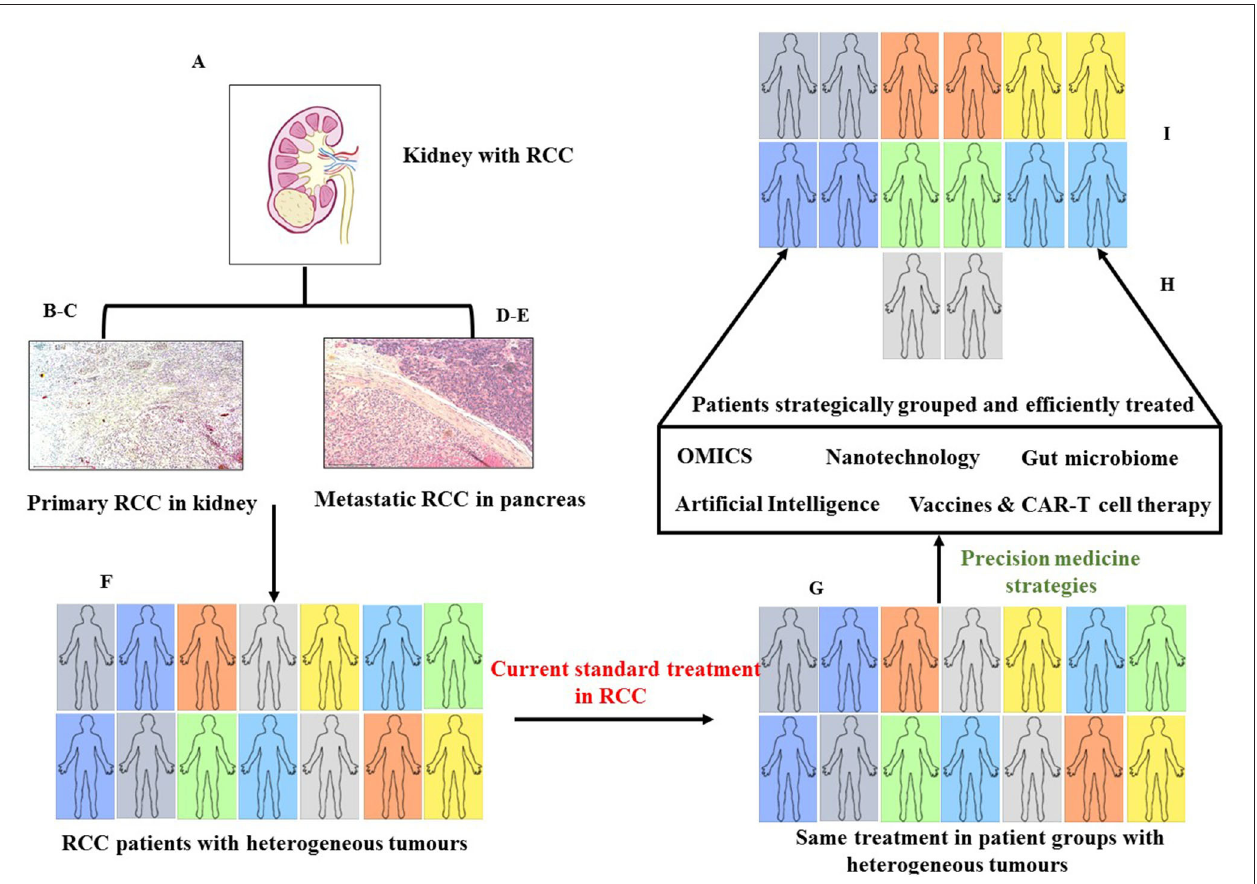
FIGURE 2 | Role of precision medicine (PM) in RCC. (A) Hematoxylin and Eosin (H & E) staining of human kidney with RCC, (B) H & E of primary RCC showing typical epithelial nests of RCC cells with clear cytoplasm (Magnification: 100X), (C) adjacent normal kidney tissue, (D) metastatic RCC invading the pancreas of a patient tissue, (E) adjacent normal spleen in a patient tissue (Magnification: 100X). (F) heterogeneity in RCC patients due to diverse clinical and environmental factors, (G) current practice of treating patients – every patient treated with same standard drugs resulting in treatment failure and secondary resistance, (H) precision medicine approach utilizing data obtained from various platforms and stratifying patients with personalized treatments, (I) individualized treatment (PM) resulting in better clinical outcomes for patients.